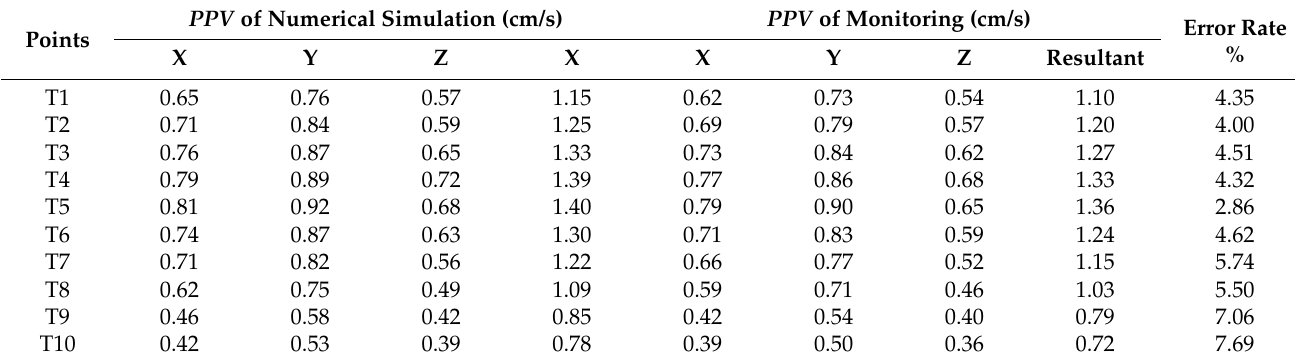
Table 7. Error rate comparison between simulation and field results.